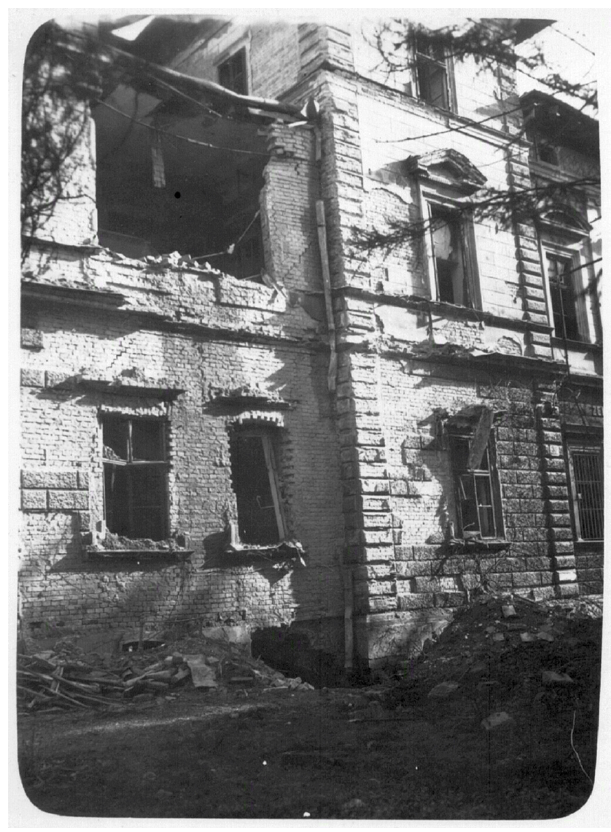
Figure 5. Damaged main building in 1944 (ZAMG